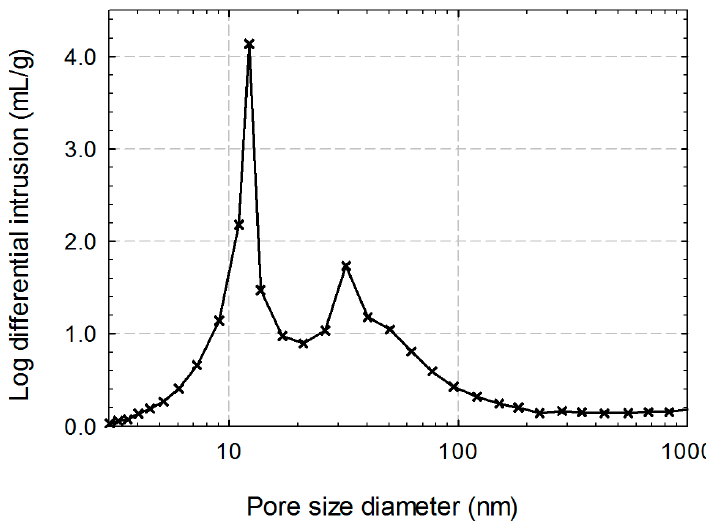
Figure 8. Pore size distribution of the silica-alumina nanoparticles.